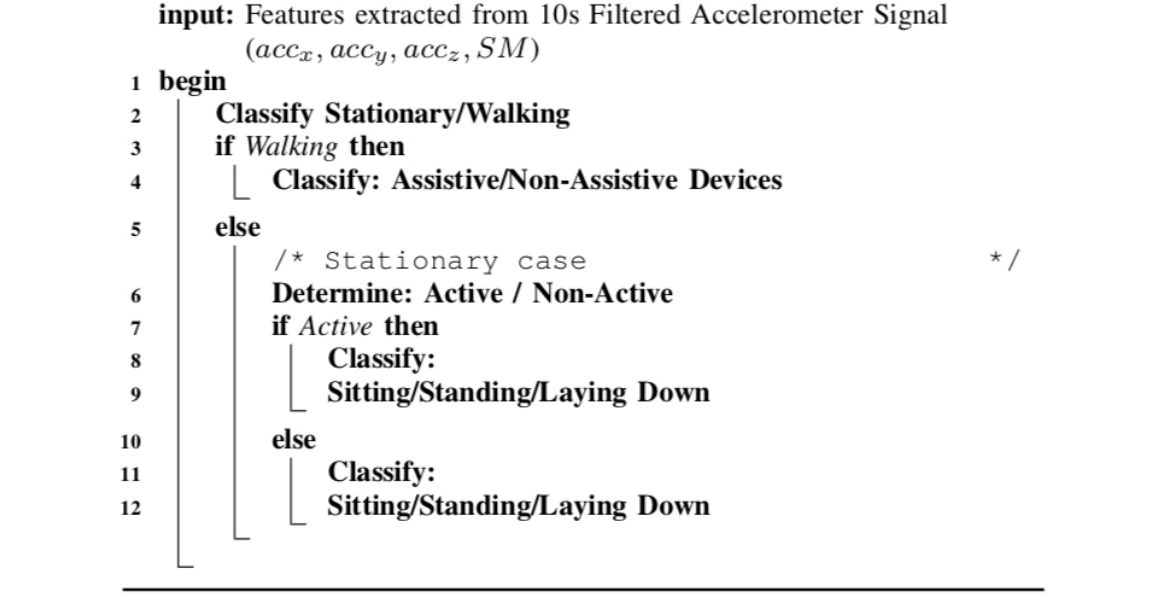
Figure 3. Hierarchical Activity Recognition Pseudo